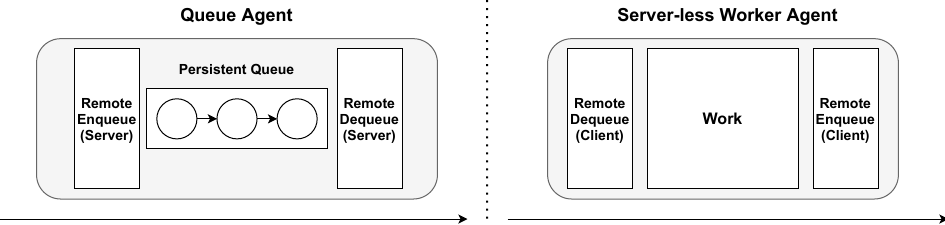
Figure 10. Queue agent and server-less worker agent. The agent to the left contains a single queue without any analysis. The agent to the right does not have any servers and receives items by making requests through clients on both